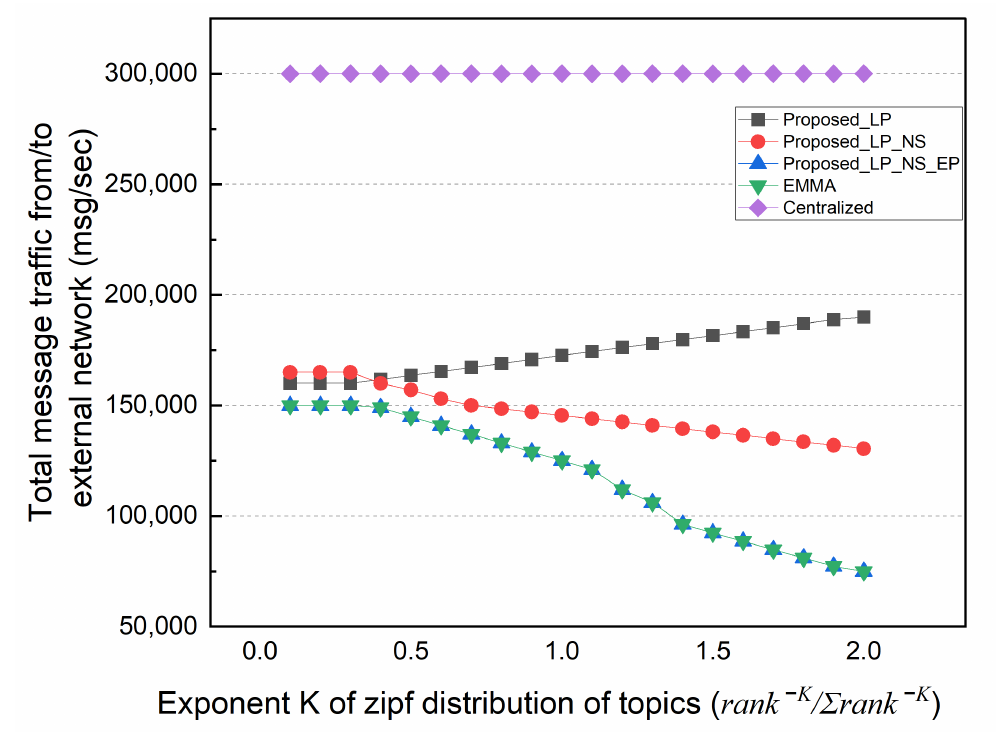
Figure 14. Message traffic between external networks according to topic popularity.